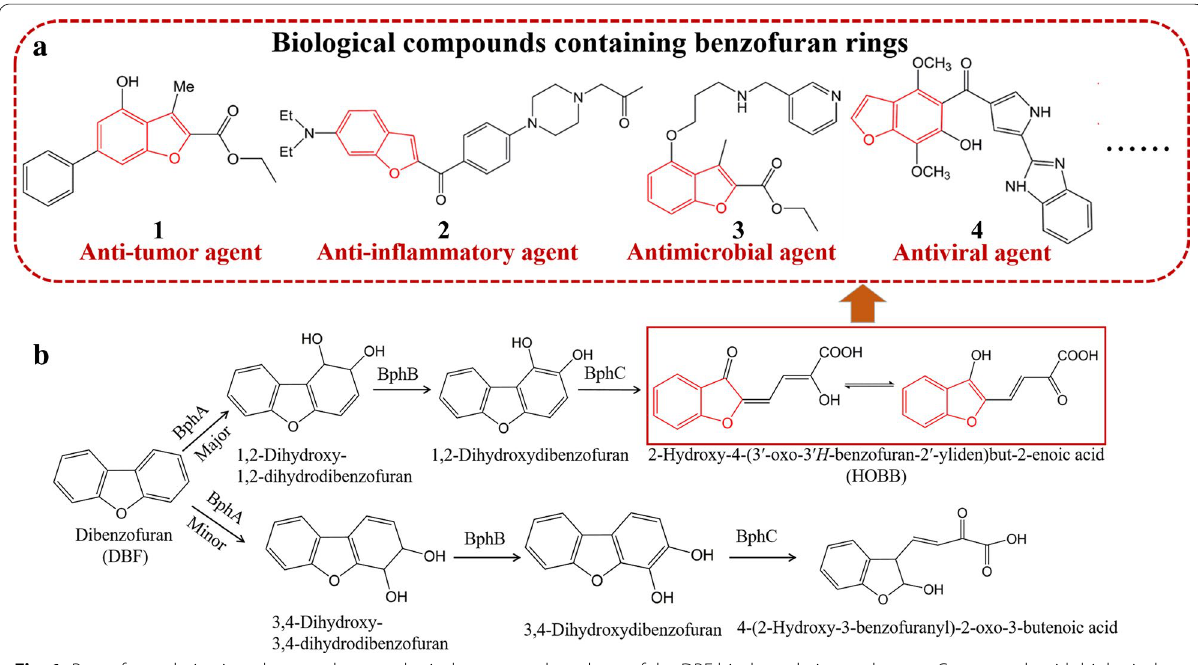
Fig. 1 Benzofuran derivatives that are pharmacological agents and products of the DBF biodegradation pathway. a Compounds with biological activities used in pharmacology. ( 1 ) 4-Hydroxy-3-methyl-6-phenylbenzofuran-2-carboxylic acid ethyl ester showed selective and potent cytotoxicity against tumors (Hayakawa et al. 2004a, b). ( 2 ) Compound 2 was found to be the most potent anti-inflammatory agent (Ma et al. 2016). ( 3 ) RO-09-4609 is a basic antifungal agent (Nevagi et al. 2015). ( 4 ) Hit compound 4 has a high therapeutic index in HIV inhibition (Khanam and Shamsuzzaman 2015). b HOBB (a benzofuran derivative) is the main product of DBF catalysis by BphA, BphB, and BphC in the lateral degradation pathway of Pseudomonas putida strain